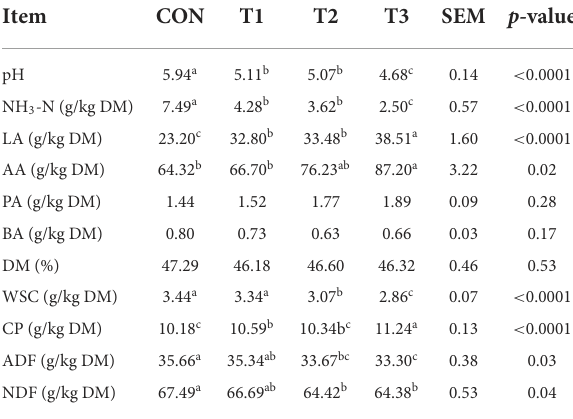
TABLE 2 Fermentation characteristics of native grass ensiled with various lactic acid